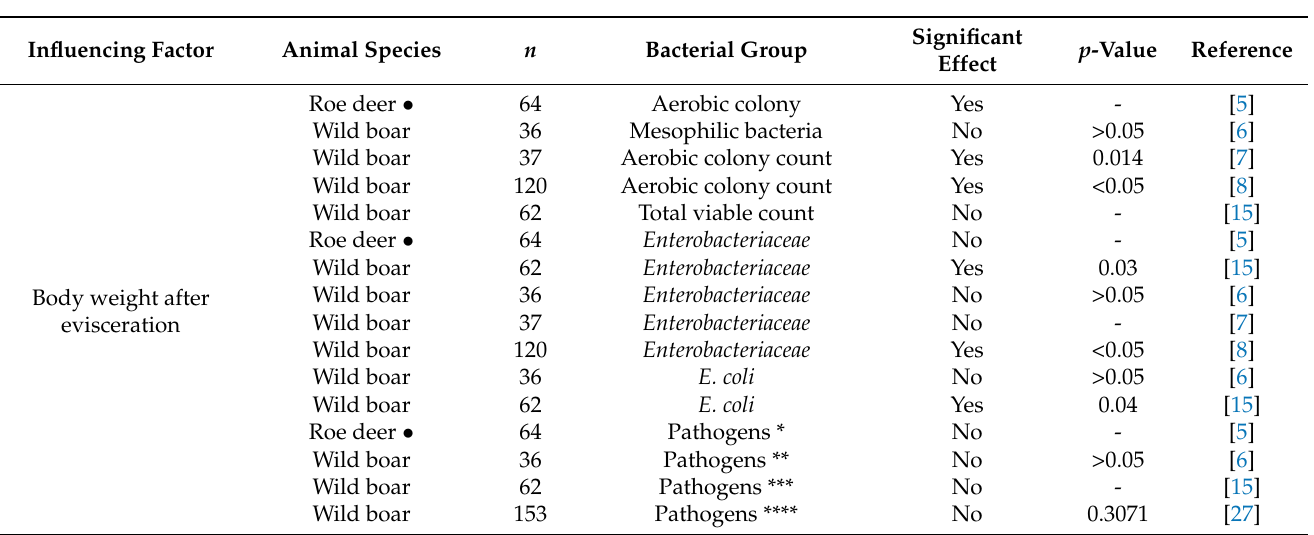
Table 4. Animal-related factors that may influence the initial microbial load of game carcasses including animal species, sample size, p -value and bacterial group examined, reported in the original research